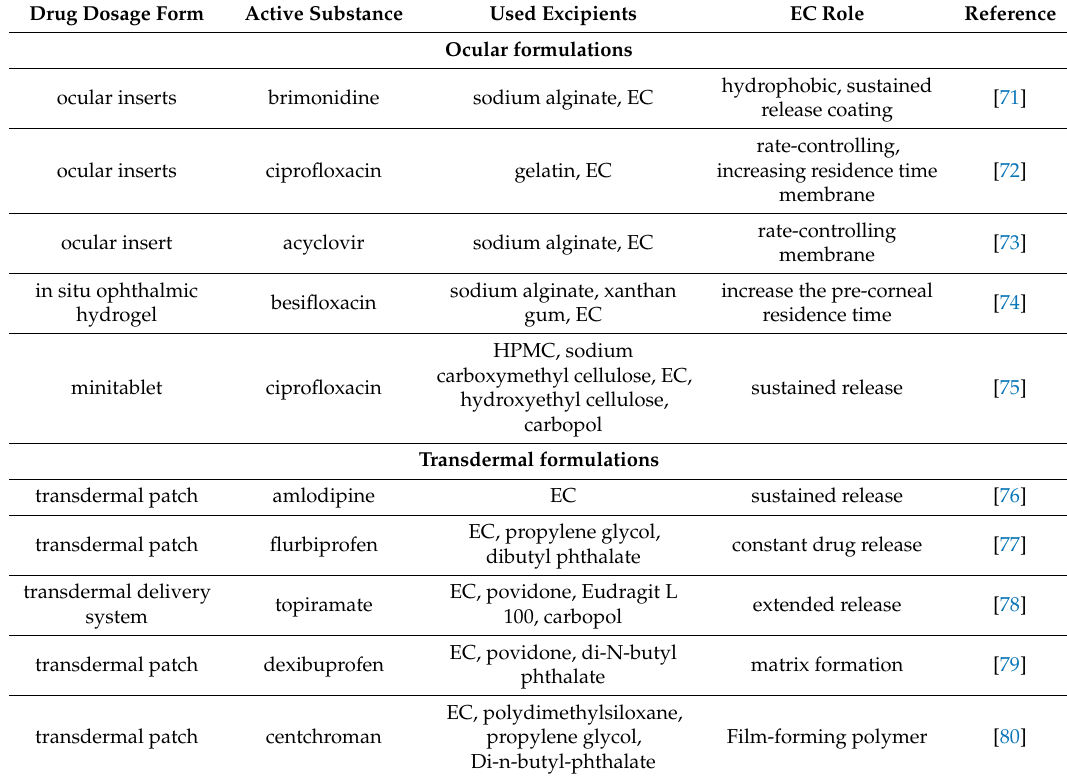
Table 3. Examples of ocular and transdermal delivery systems based on